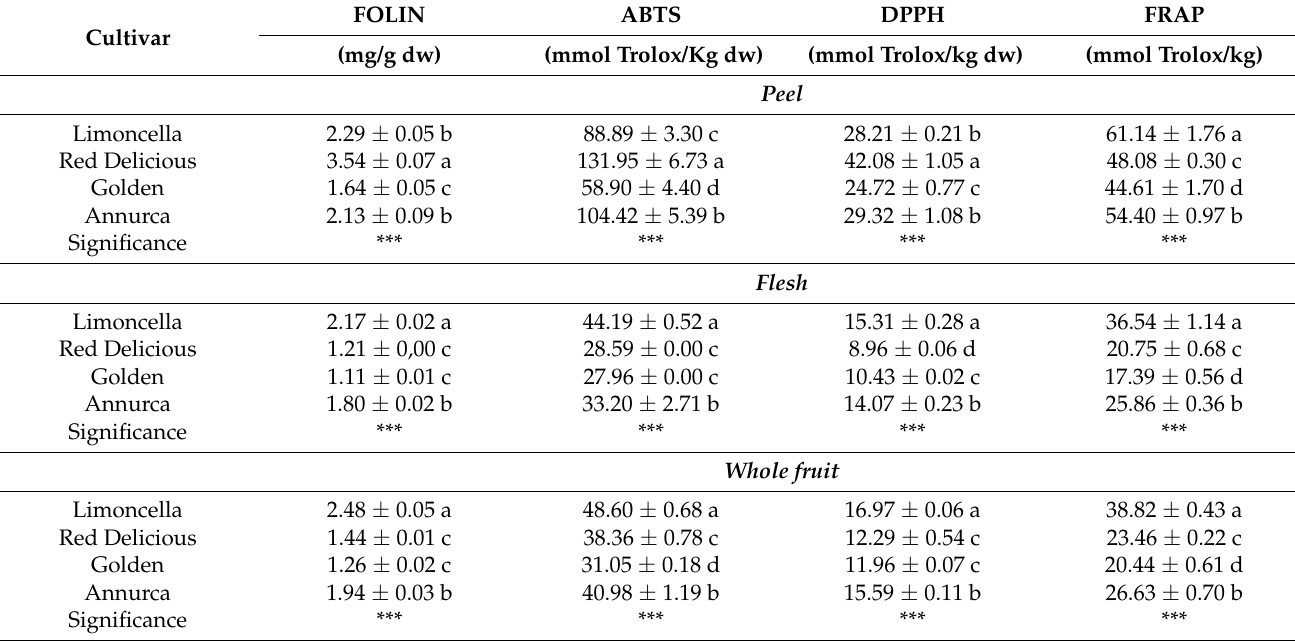
Table 2. Antioxidant activity (ABTS, DPPH, and FRAP) and total polyphenolic content (FOLIN) in Limoncella, Red Delicious, Golden Delicious, and Annurca apples. Each value represents the mean ± SD of three biological and two technical replicates. The same letter indicates not significant differences according to Tukey’s multiple range test (*** p <